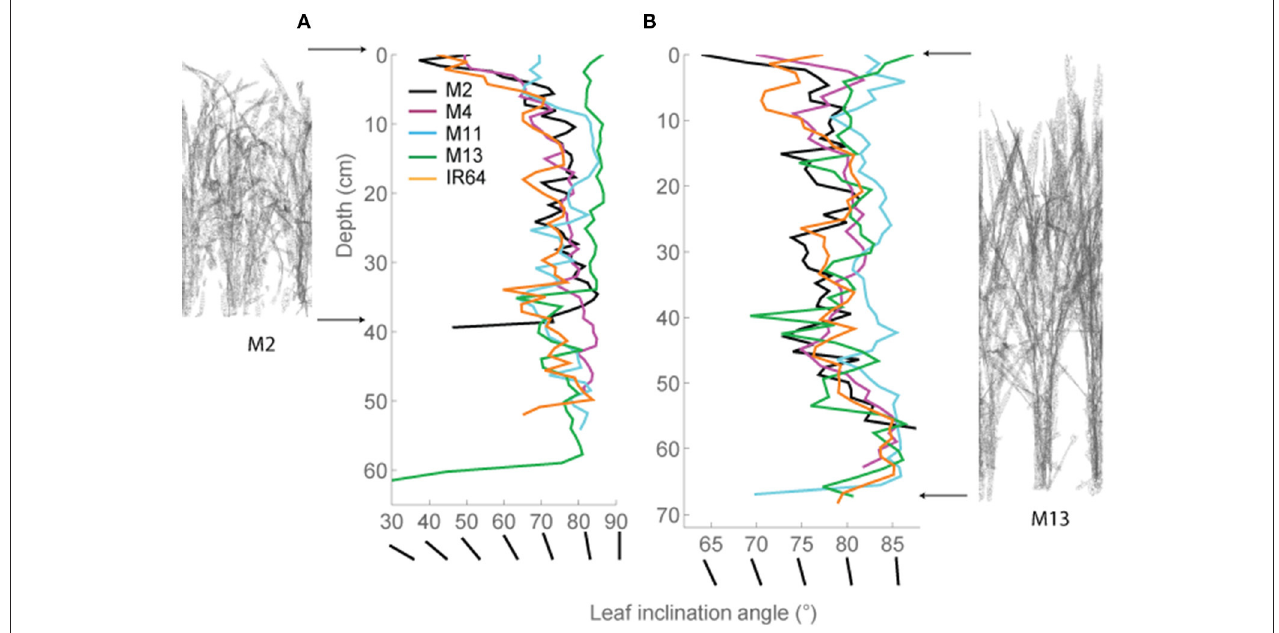
FIGURE 3 | Modeled leaf inclination angles throughout depth (i.e., distance from the top) in the canopy. (A) GS1 and (B) GS2. Representations of M2 (left) and M13 (right) are shown at the side to make interpretation easier. As an additional visual aid, we have added lines of different angles which correspond to the leaf angles shown on the X-axis. The average triangle inclination angle throughout the horizontal subsection was calculated with respect to vertical, where a leaf inclination angle toward 0 indicates a more horizontal leaf and an inclination angle of 90 indicates a more vertical leaf. M2, M4, M11, and M13 refer to Shan-Huang Zhan-2 (SHZ-2), IR4630-22-2-5-1- 3, 157 WAB 56-125, and Inia Tacuari,